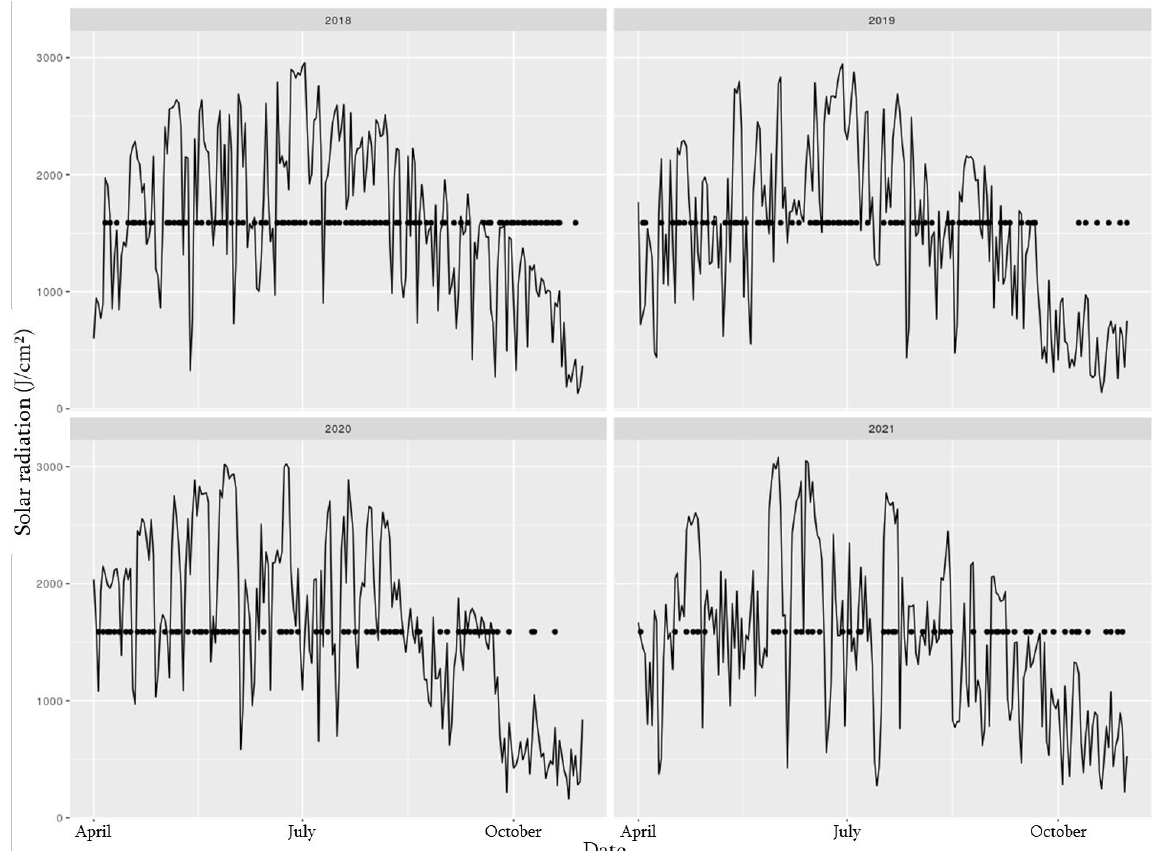
Figure 4. Data acquisition dates (points) and their link to the mean daily solar radiation (line and shown y values, in J/cm 2 ) received on all the Agromet stations.